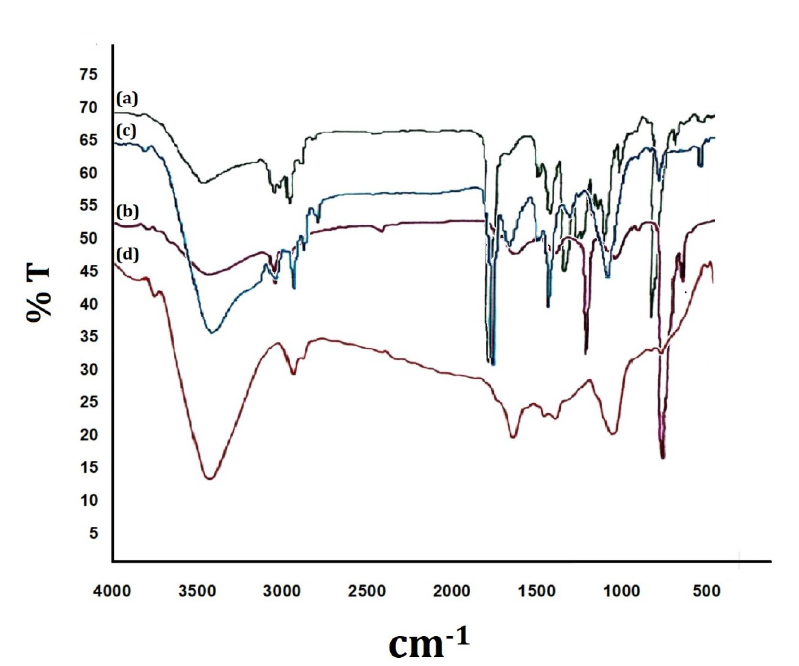
Fig 5. FTIR chromatogram of soil buried PHB film after the degradation by Aeromonas caviae Kuk1-(34) sp. The functional groups changes were compared with each film after incubation with (A) Control PHB film without treatment, Aeromonas caviae Kuk1-(34) sp after (B) 15 days (C) 30 days (D) 45 days.